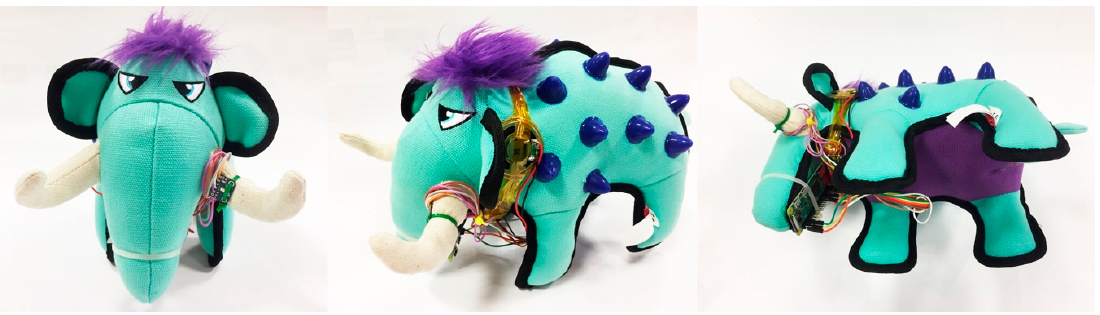
Figure 2. MAmIoTie prototype and internal hardware elements used during the development and evaluation of this work (hardware will be embedded into the toy in the production